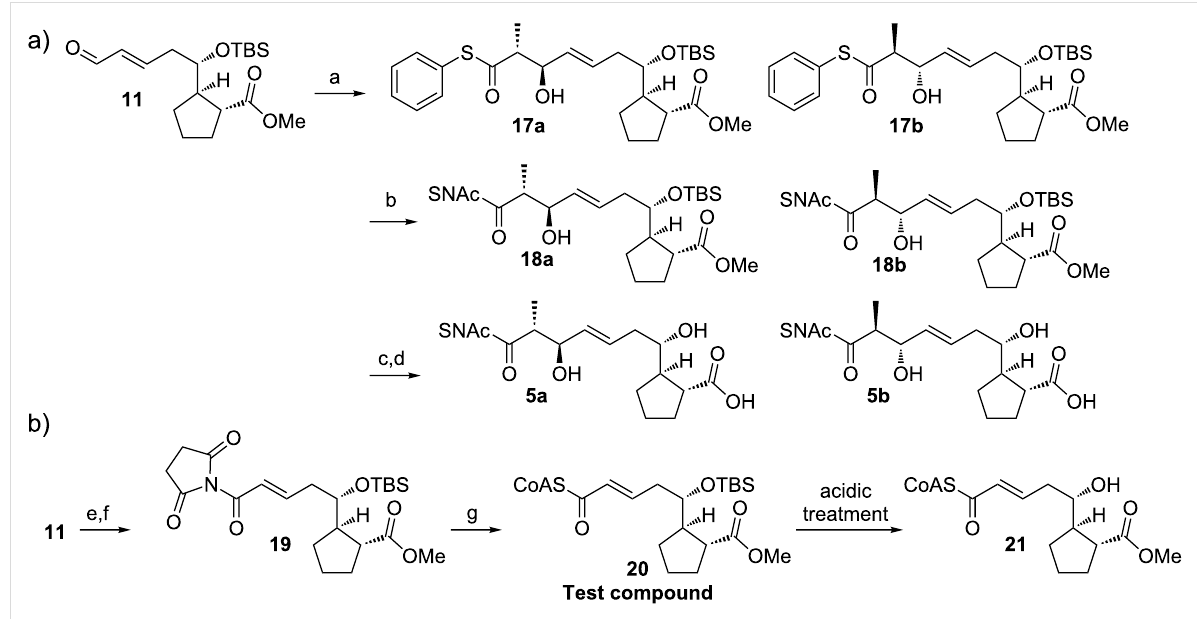
Scheme 3: Synthesis of the BorDH3 substrates. a) Thiophenolpropionate, Cy 2 BCl, Me 2 EtN, Et 2 O, − 78 °C to − 20 °C, 16 h (57% over two steps from 12 ); b) HSNAc, Et 3 N, DMF, rt, 16 h (70%); c) THF/HCOOH/H 2 O (6:3:1), rt, 2 d; d) pig liver esterase, phosphate buffer, rt, 5 d (81% over two steps);